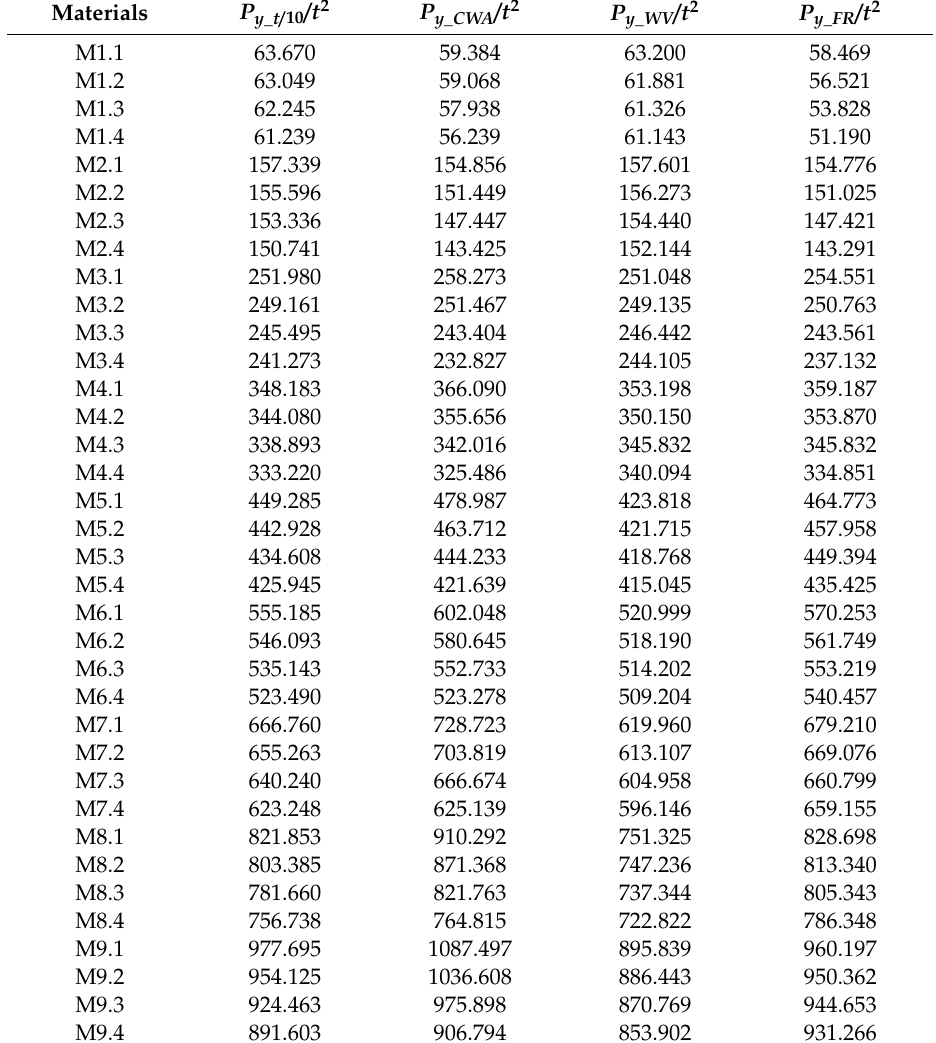
Table 2. Di ff erent identification methods to identify the value of assumed